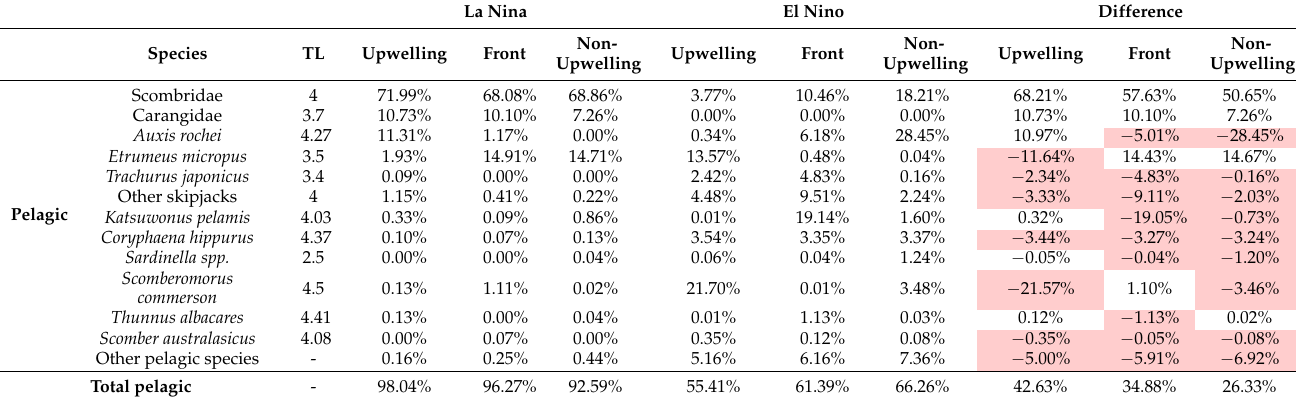
Table 4. Contributions of individual species to primary production required in La Niña and El Niño years by habitat type. La Nina El Nino Difference Species TL Upwelling Front Non- Upwelling Upwelling Front Non- Upwelling Upwelling Front Non- Upwelling Scombridae